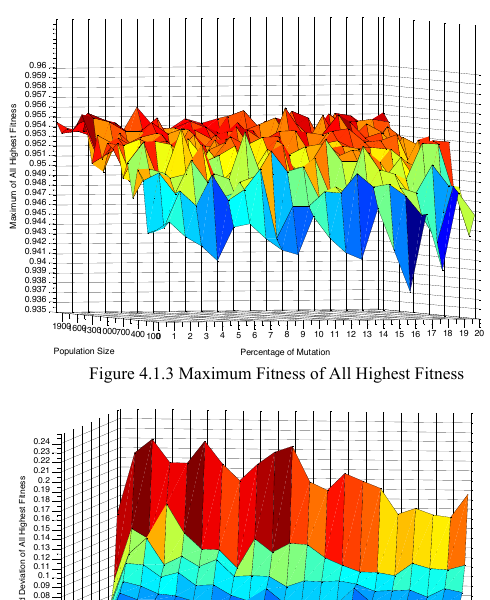
Figure 4.1.2 Minimum Fitness of All Highest Fitness